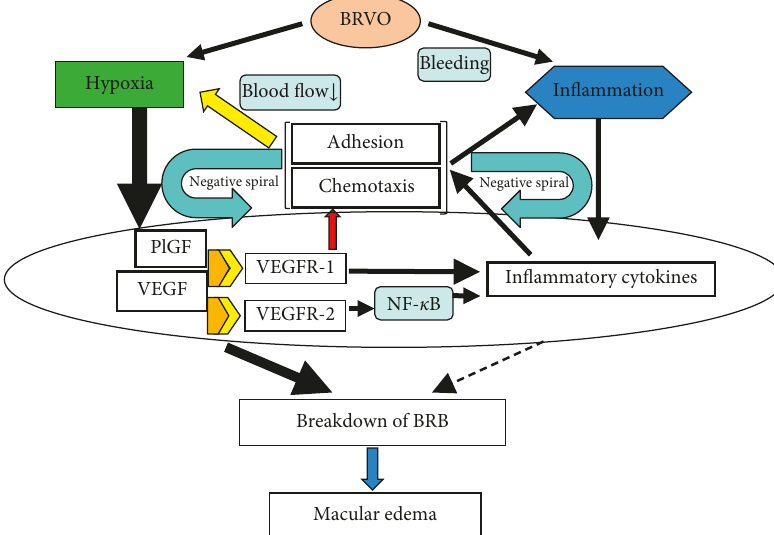
Figure 3: Pathogenesis of macular edema (hypothesis). BRVO not only causes retinal hypoxia but also produces inflammation secondary to retinal hemorrhage. As a result, expression of VEGF and inflammatory cytokines increases, resulting in disruption of the BRB with the development and progression of macular edema. Activation of VEGFR-1 by both VEGF and PlGF plays a role in recruitment of leukocytes and also upregulates expression of inflammatory cytokines. In addition, activation of VEGFR-2 by VEGF increases vascular permeability and enhances the expression of inflammatory cytokines such as MCP-1 and ICAM-1 via NF- κ B, leading to chemotaxis and adhesion of leukocytes to the vascular endothelium along with a decrease of blood flow velocity. Reduction of blood flow velocity creates a positive feedback loop, which further exacerbates retinal hypoxia. Increased leukocyte chemotaxis and adhesion also enhances inflammation, creating another positive feedback loop. According to this hypothesis, the pathological mechanism becomes more complicated and the influence of inflammation increases as BRVO becomes chronic.